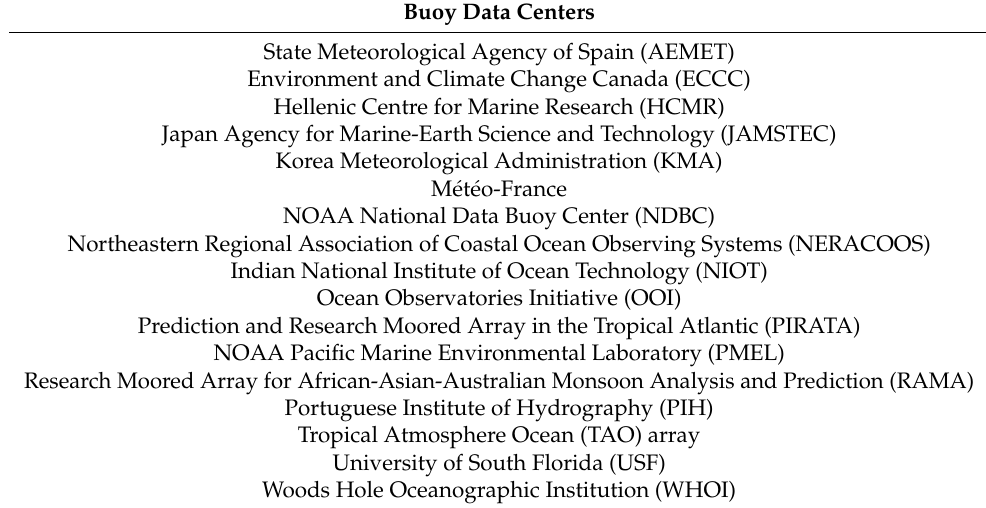
Table 1. Centers for buoy data reported through the Global Telecommunications System and used in the